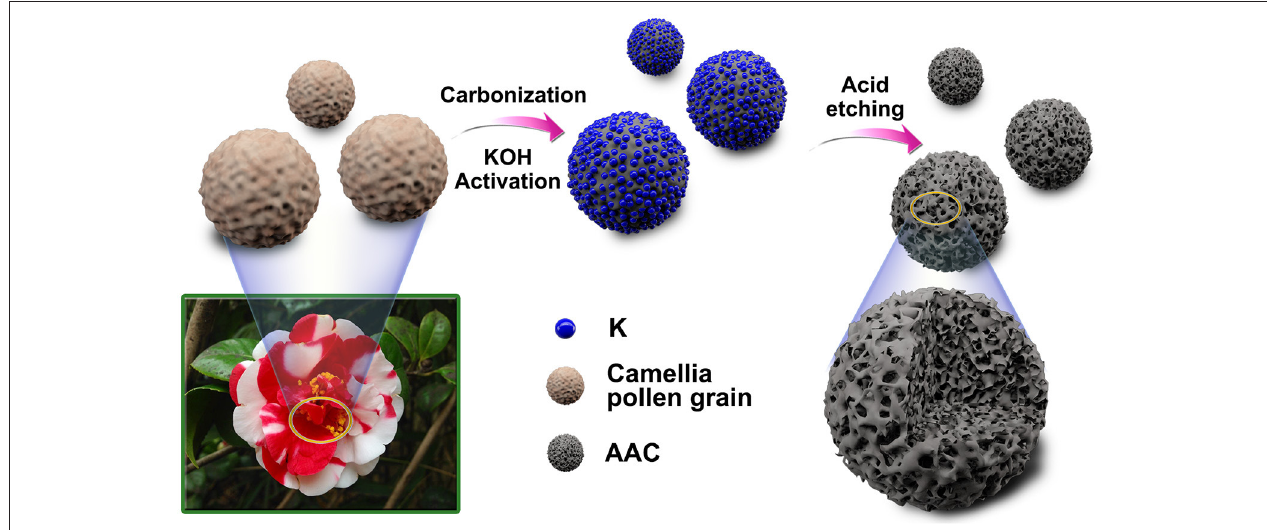
FIGURE 1 | Schematic illustration of the synthesis process for the activated amorphous carbon derived from camellia pollen